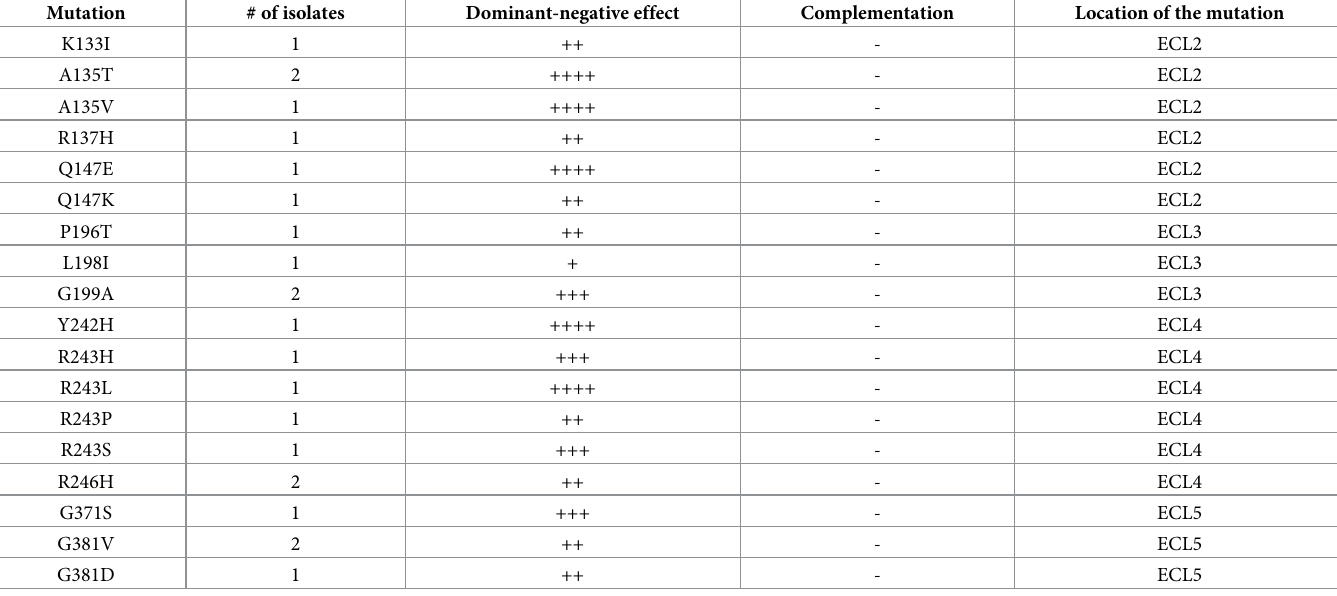
Table 1. Dominant-negative FtsW mutations isolated from the wrinkle-colony-based screen. Mutation # of isolates Dominant-negative effect Complementation K133I 1 ++ - ECL2 A135T - ECL2